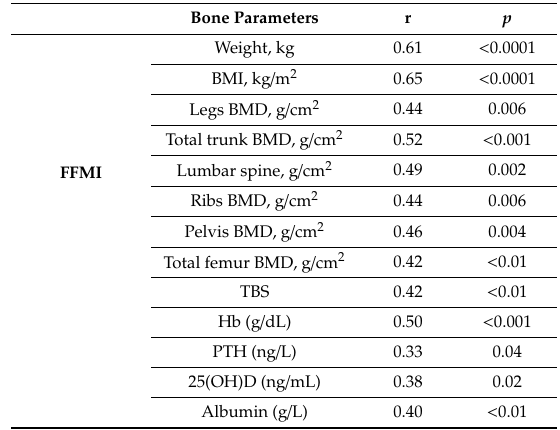
FFMI: fat free mass index. BMI: body mass index. BMD: bone mineral density. TBS: trabecular bone score. Hb: hemoglobin 25(OH) D: 25(OH) vitamin D. PTH: Parathyroid hormone. r-Spearman’s correlation coe ffi cient, p ≤